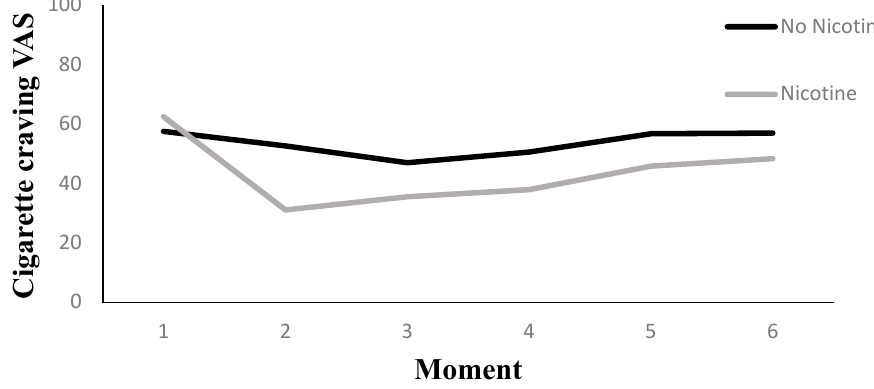
Figure 7. The interaction between moment and nicotine level in the Unipod condition for cigarette craving.